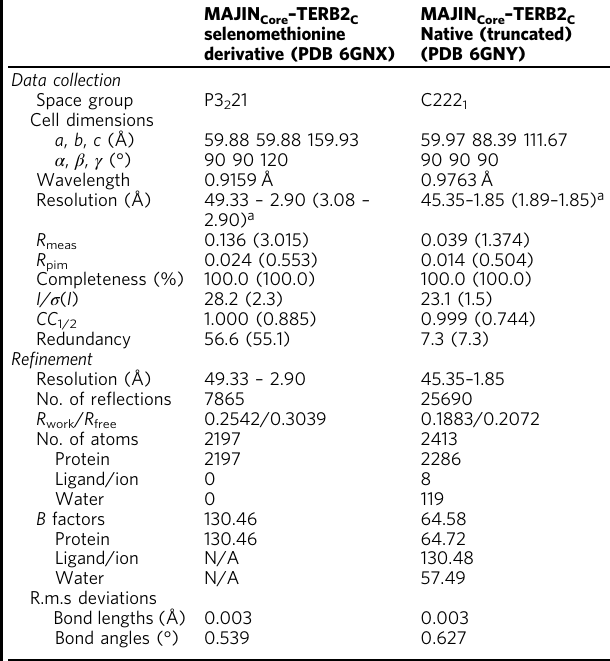
Table 1 Data collection, phasing and re fi nement